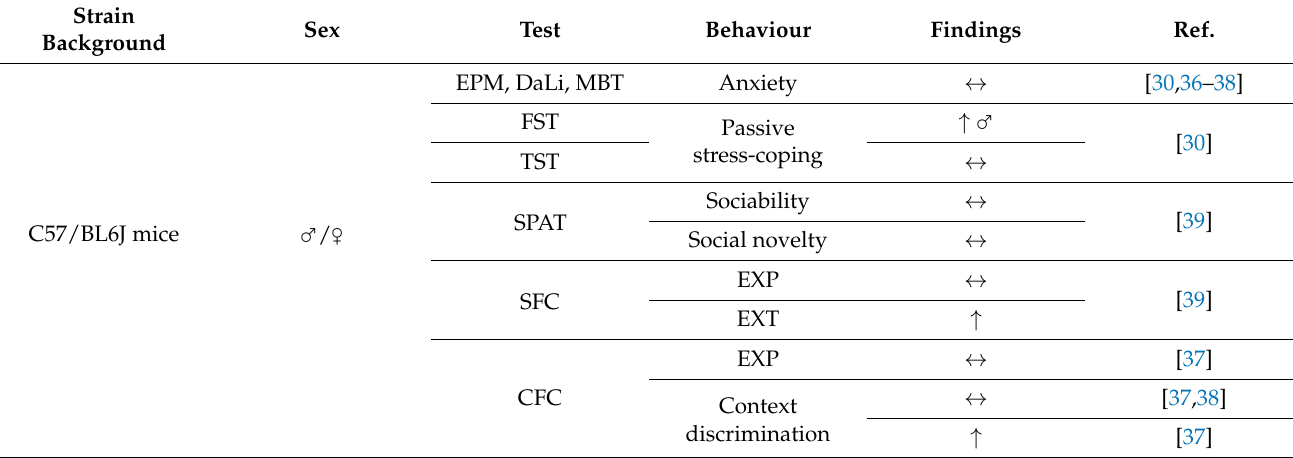
Table 2. Summary of the behavioural phenotypes observed in male and female mice with targeted disruption of the NPSR1.